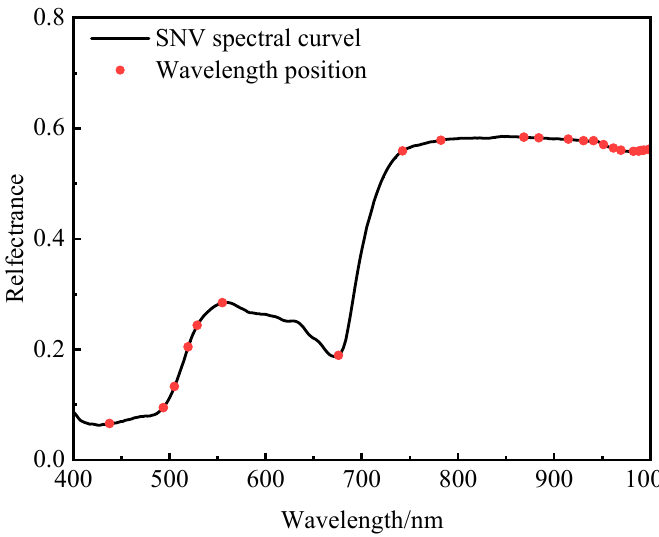
Figure 8. Characteristic wavelengths of the SNV spectral curve selected using the